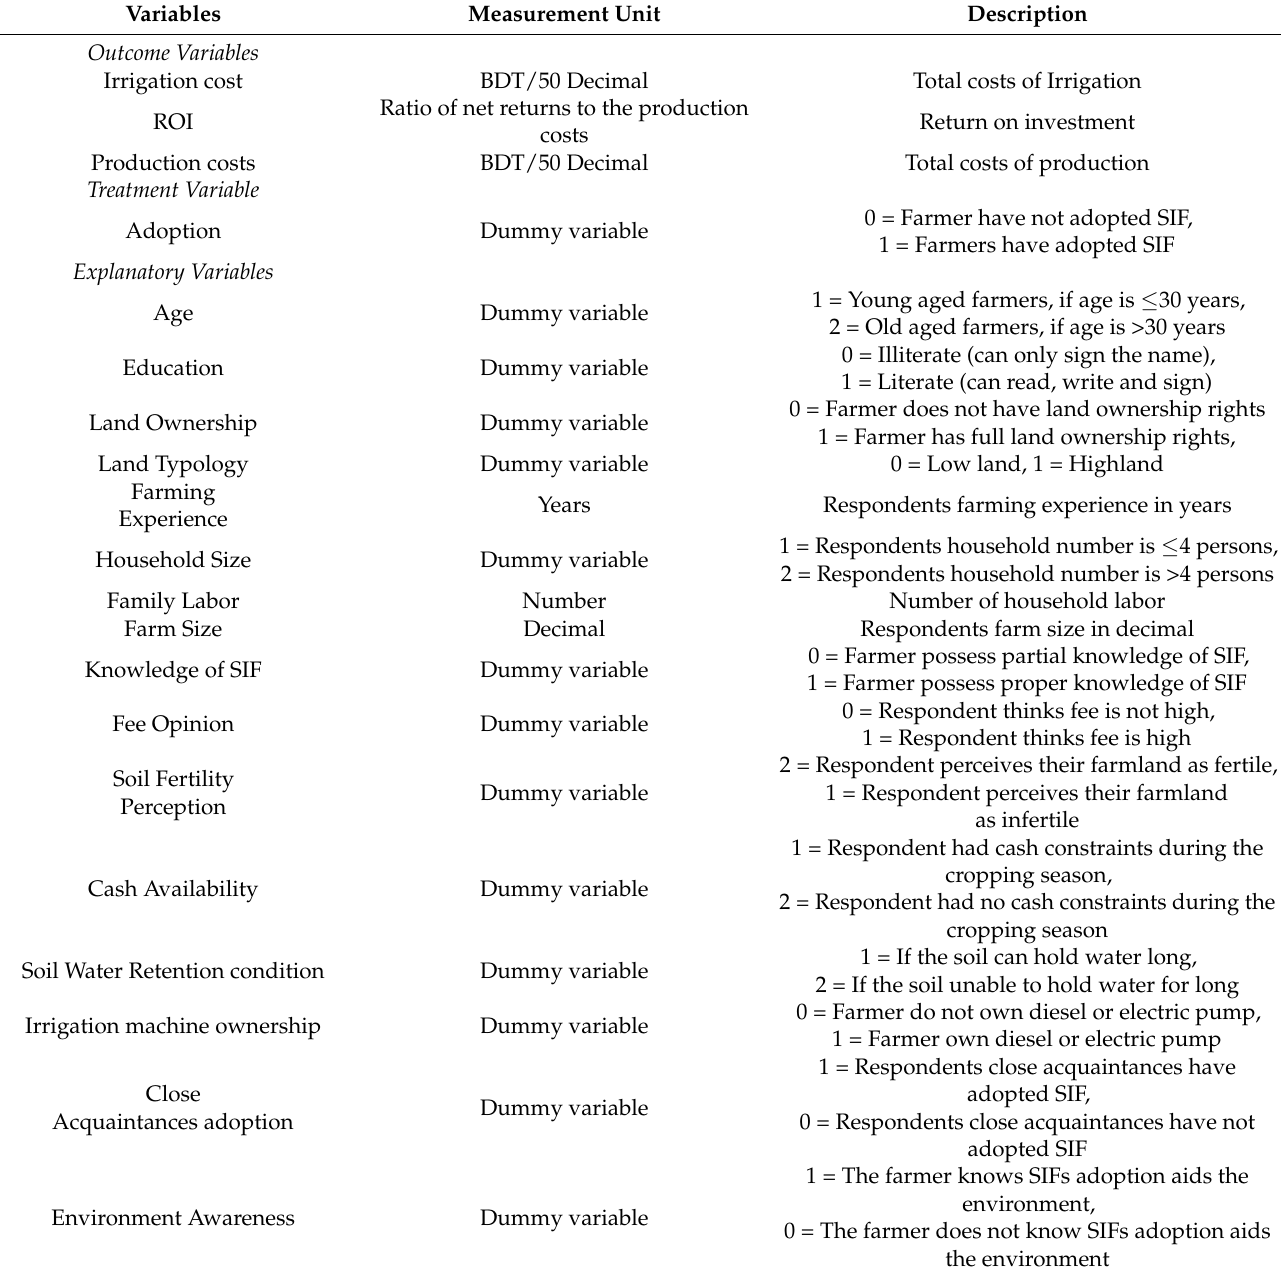
Table 1. Variables used in different